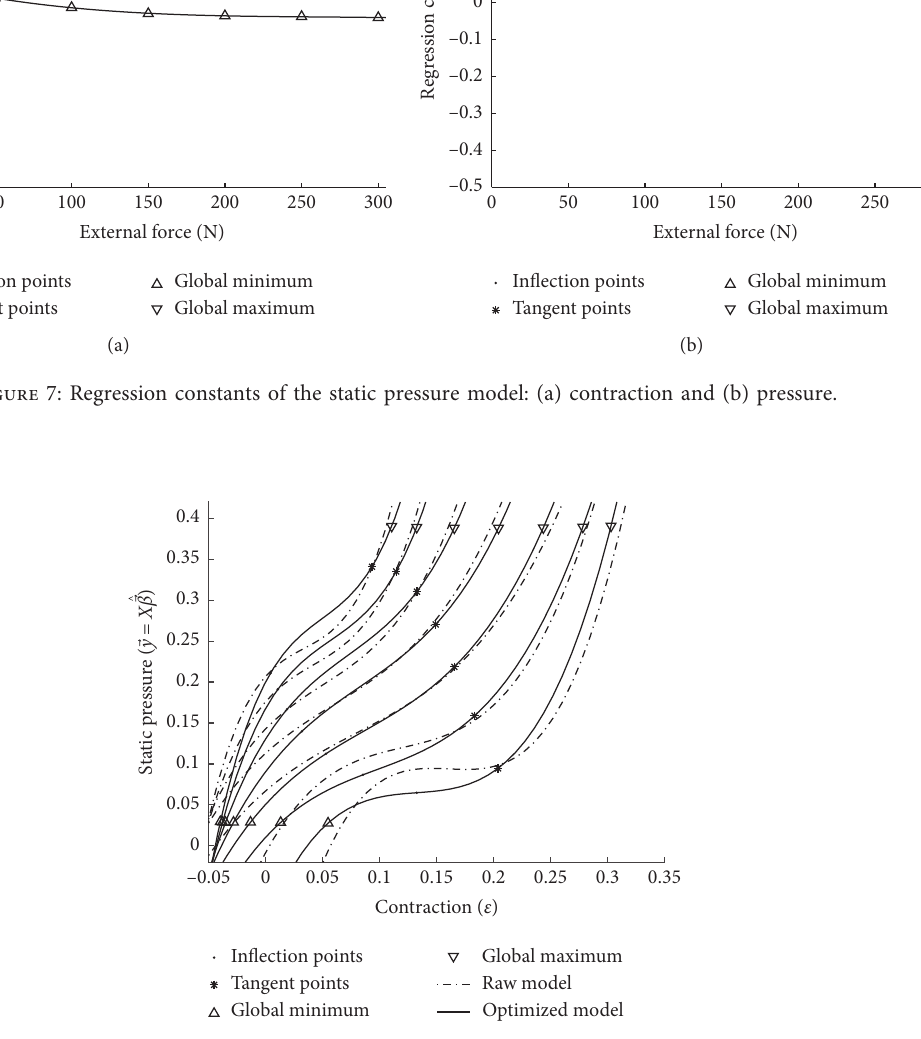
Figure 8: Optimized static pressure model using polynomial parameterization of third